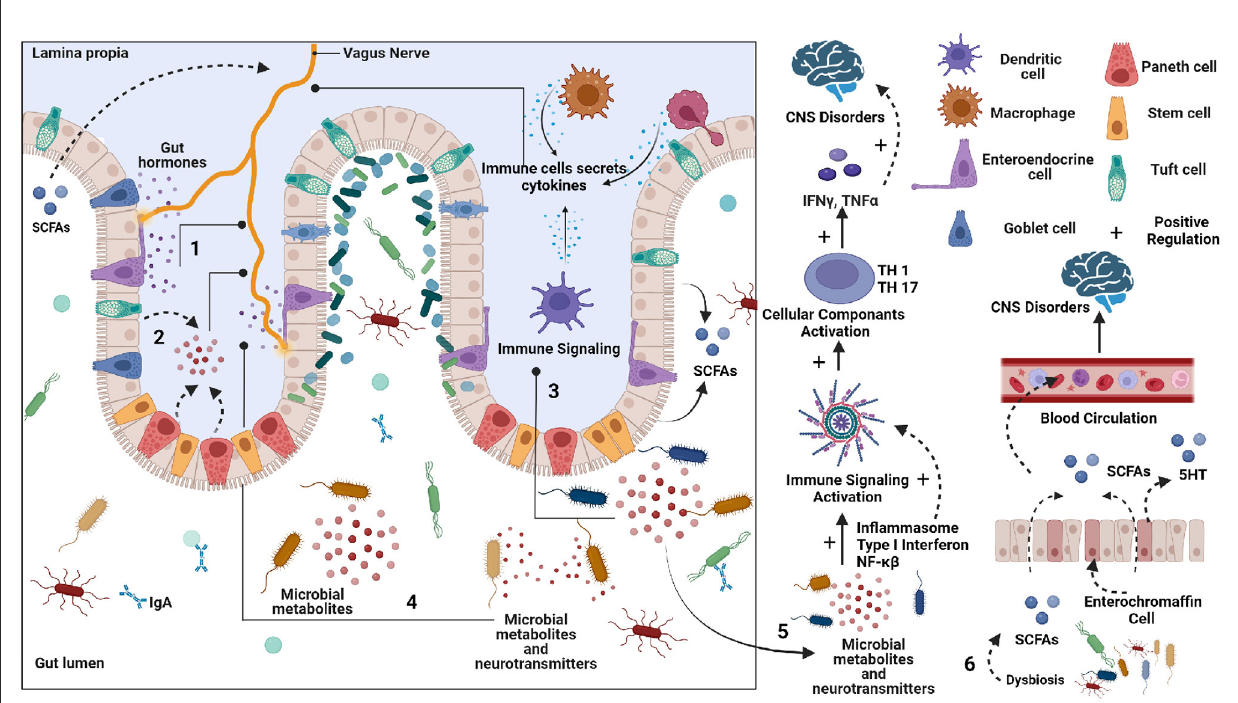
FIGURE1 Schematic representation of potential pathways by which gut can affect the Central nervous system (CNS). 1. Enteroendocrine cells (EECs) secreted various peptides/amines can affect vagus nerve signaling to the brain. 2. Neurotransmitter precursors and metabolites are formed by gut microbes that circulate to the brain. Some bypass the blood-brain barrier. 3. The pathogenic microbes can elicit an immune response, which can produce cytokines that circulate from the blood to the brain. 4. Microbial metabolites and neurotransmitters can stimulate an Enteric nervous system (ENS). 5. The Neurotransmitter precursors and metabolites produced by microbes can alter brain physiology. 6. The short chain fatty acid (SCFA) produced by gut microbes can affect brain